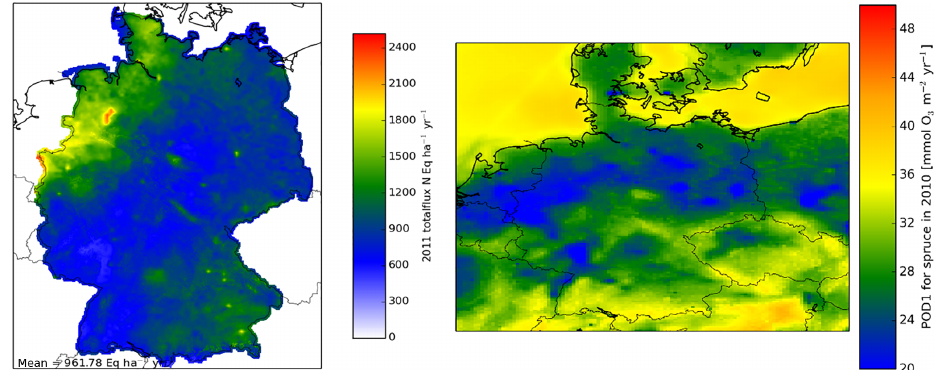
Figure 1. Deposition of nitrogen (oxidized + reduced) over Germany, assessed using the LOTOS–EUROS model in combination with ob- servations of wet deposition (Schaap et al., 2017), and phytotoxic ozone dose for spruce (Bender et al.,